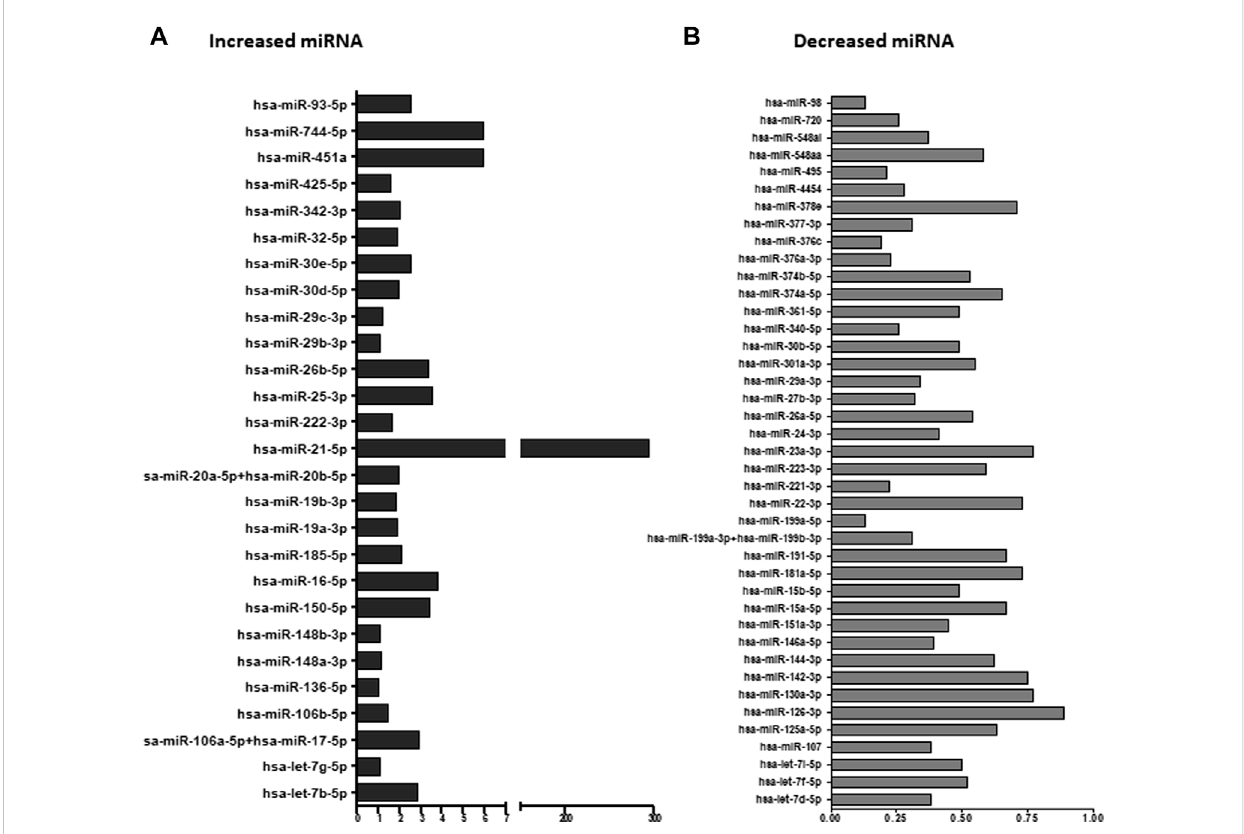
FIGURE 3 Ratioofextracellularvesicle(EV)miRNAfromwomenwithgestationalvascularcomplications(GVC)comparedtohealthy-pregnantwomen(HP).EV pellet miRNA was pro fi led using the NanoString platform and analyzed with nSolver Software 3. The graphs present the ratios of Average EV miRNA from two samples of women with GVC compared to average EV miRNA from two samples obtained from HP women. miRNA expression was greater in EV pellets from the GVC than the HP group (A) and lower in EV pellets from the GVC compared to the HP group (B)